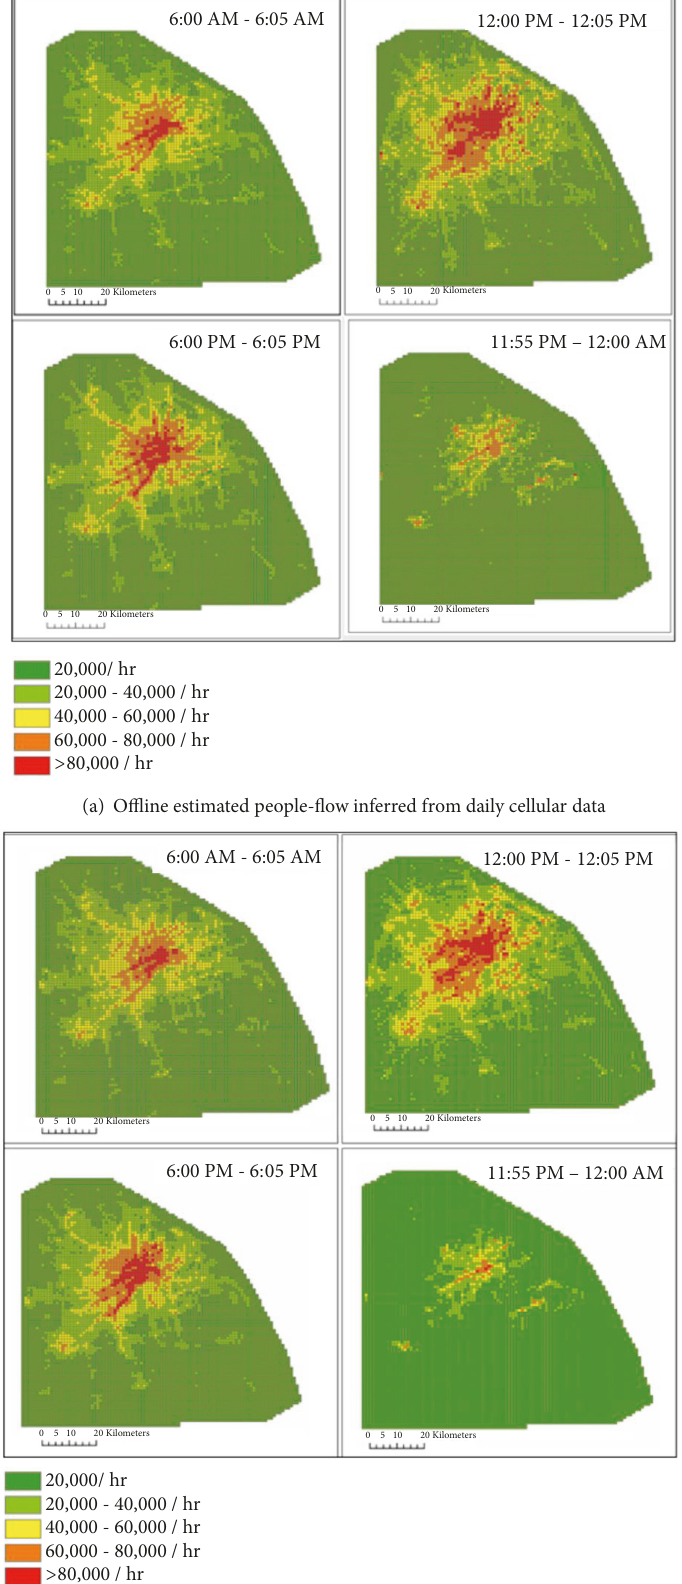
(b) Online predicted people-flow from real-time cellular data Figure 7: Cooperation of based people-flow data and predicted